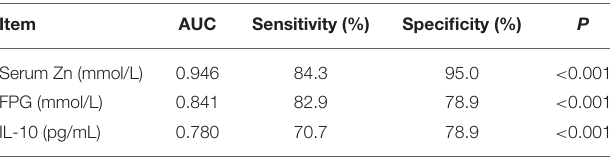
TABLE 3 | Sensitivity and specificity for potential predictors of DN by ROC curve analysis.